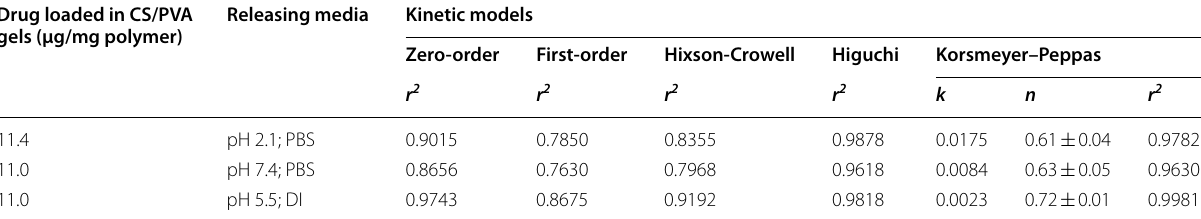
Table 3 Kinetic models of CS/PVA irradiated hydrogel (50/50): drug-release rate constants, diffusion exponents, diffusion types, and regression values in diverse